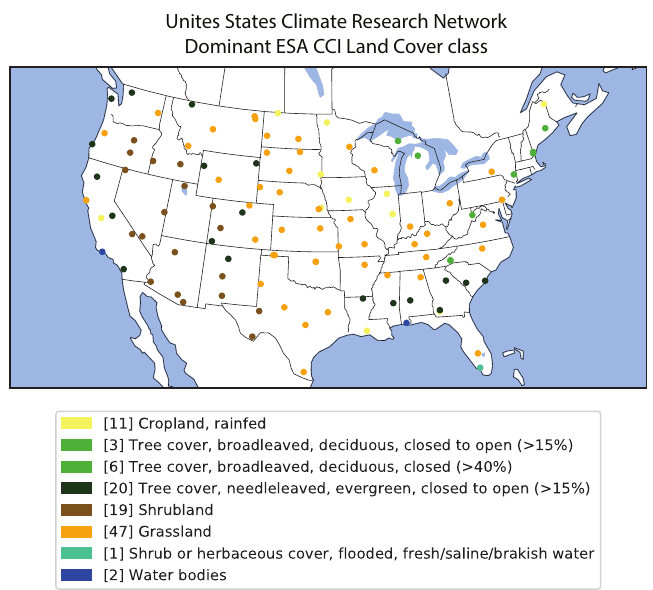
Figure 2. United States Climate Research Network (USCRN) Soil Moisture Stations, coloured by ESA CCI Land Cover Class. The numbers in square brackets indicate the number of occurrences of each type.